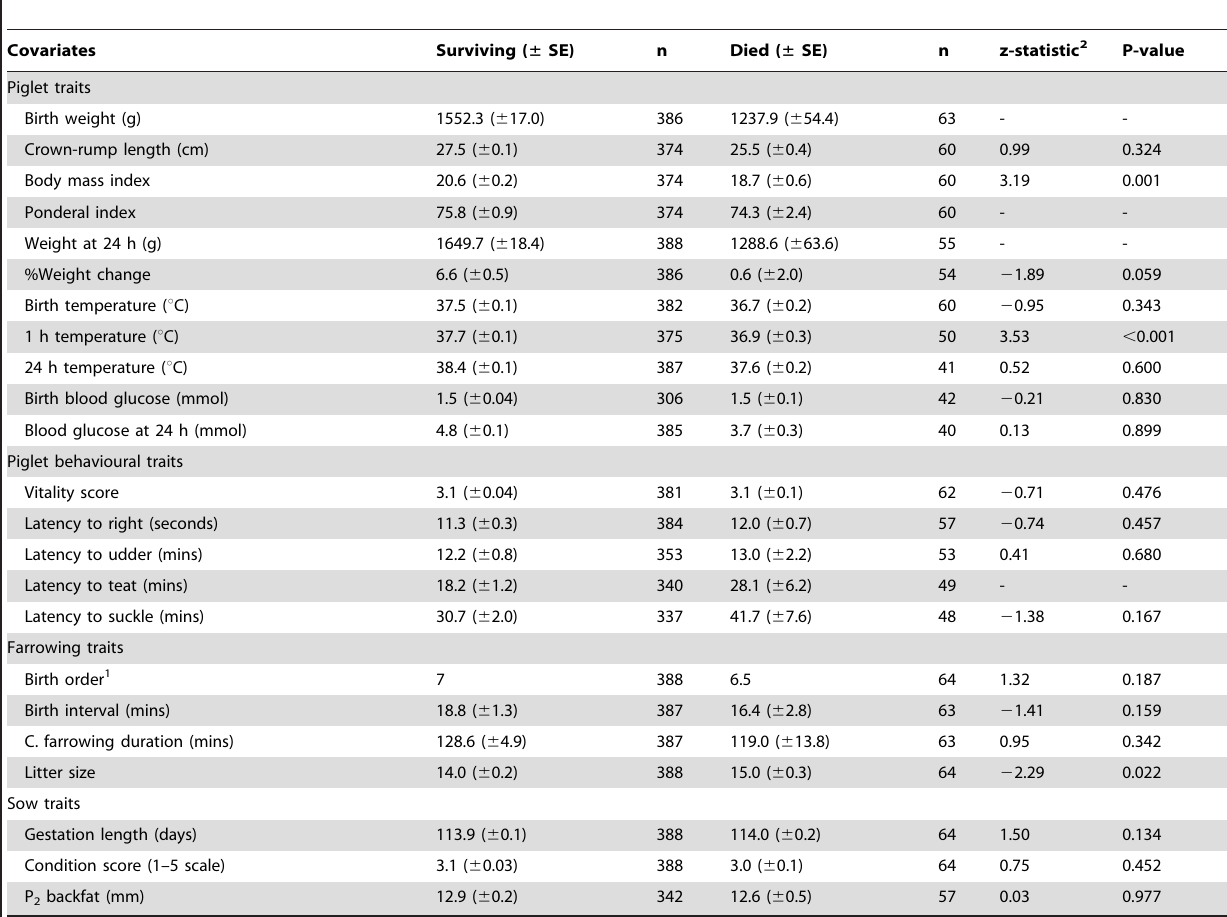
Table 3. Postnatal survival indicators (means and standard errors (SE)) comparing surviving piglets with those born alive but dying